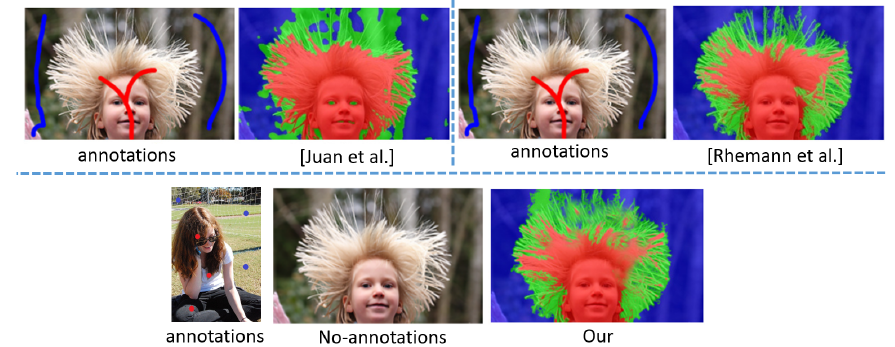
Figure 12. This figure shows trimap segmentation results. We compare our method with Interactive Trimap segmentation methods [14,17], the experimental results showed that our model deliver semantic representation between query and support images, and the generated trimaps are accurate